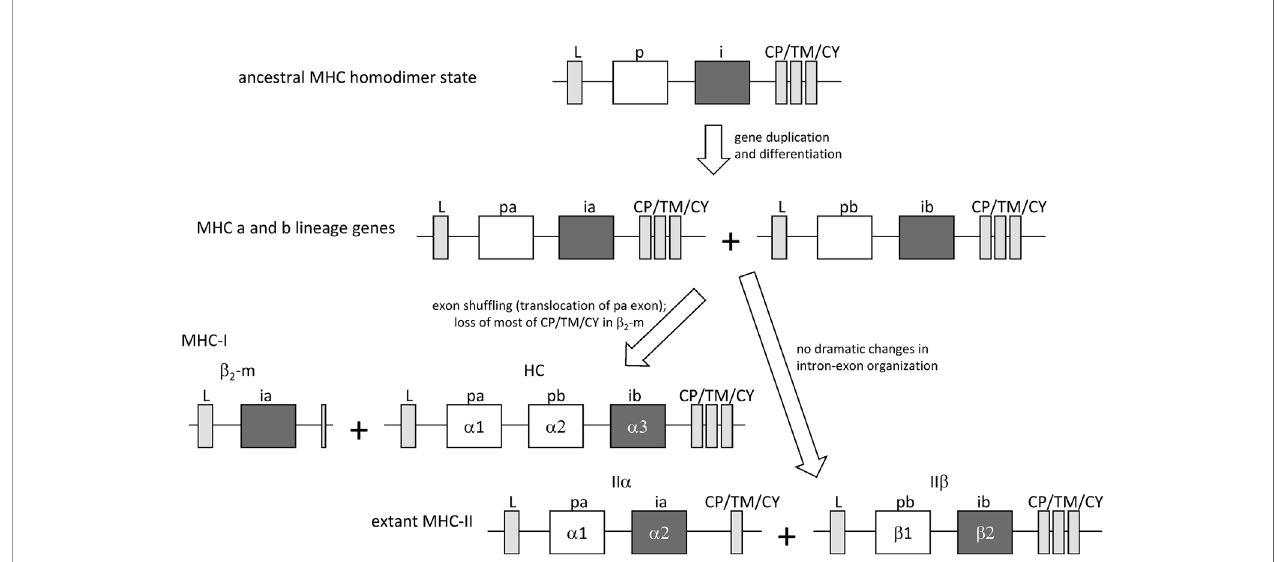
FIGURE 1 | The “ II-to-I ” evolution model, at the gene level, for the creation of MHC-I and MHC-II from an MHC-II-like ancestor, similar to as proposed by Kaufman et al. (20, 21). In the model, MHC-I (HC + b 2-m) and MHC-II (II a + II b ) gene sets were derived from an ancestral MHC-II-like gene that encoded a homodimer- forming molecule with a peptide binding domain (p) and an IgSF domain (i). The ancestral gene duplicated, followed by differentiation into lineages “ a ” (with domains pa and ia) and “ b ” (with domains pb and ib) that together encoded a heterodimeric structure. After this, an exon shuf fl ing event involving translocation of the pa domain exon was part of the creation of the MHC-I genes HC and b